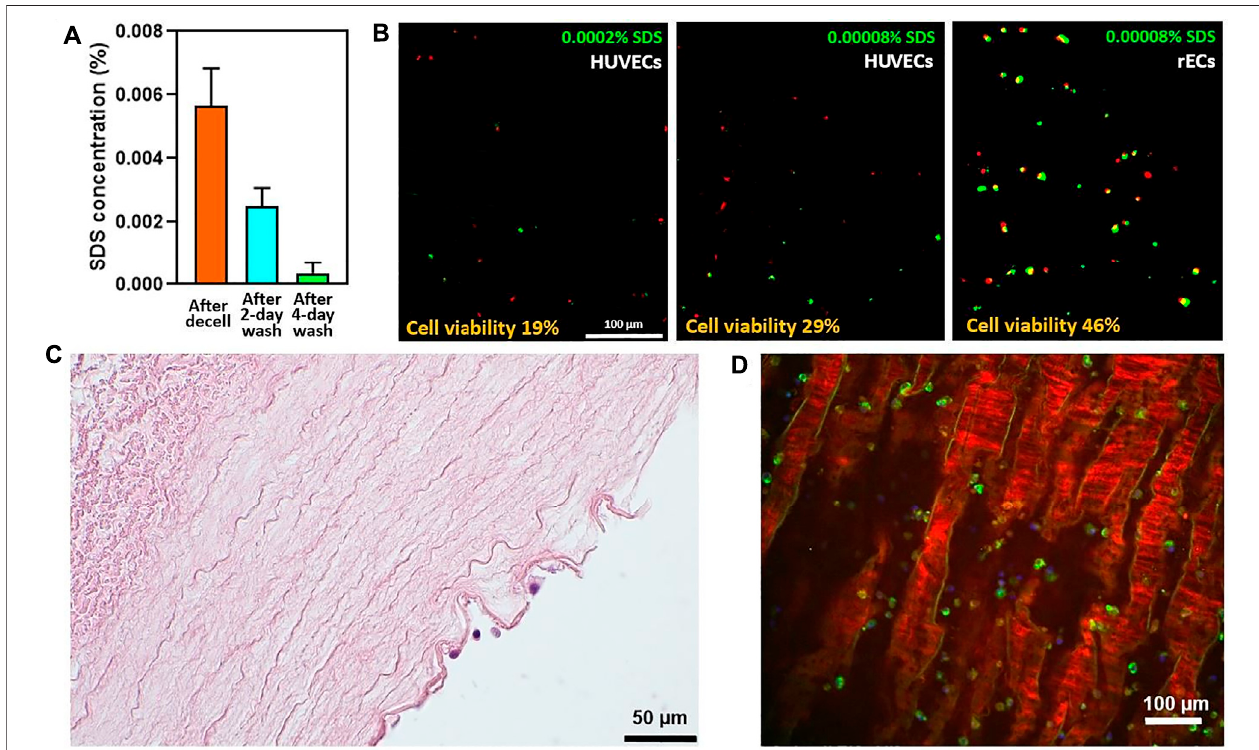
FIGURE 8 | Endothelial cell culture in arterial scaffolds after 1 day: (A) SDS concentration with successive PBS washes; (B) Live/Dead assay images of three different 1-day seeding with HUVECs and rECs at different SDS concentration; live cells are depicted in green and dead cells in red; (C) Cells (dark blue) adhered to the ECM oftunica intima (H&Estaining,vessel cross-section); (D) Vesselscaffoldsurfacewithattached cells(bluefornuclei;green forcytoskeleton)imagedby fl uorescence microscopy; red fi bers represent collagen I from the